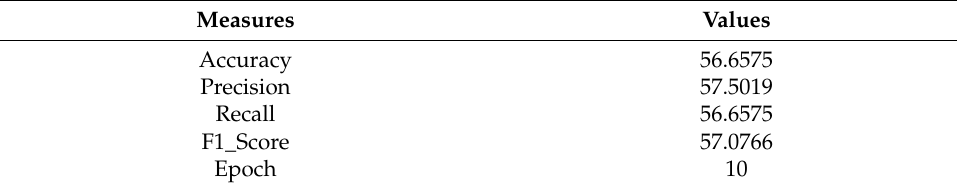
Table 2. Measures of 1D-CNN model for noisy LFM